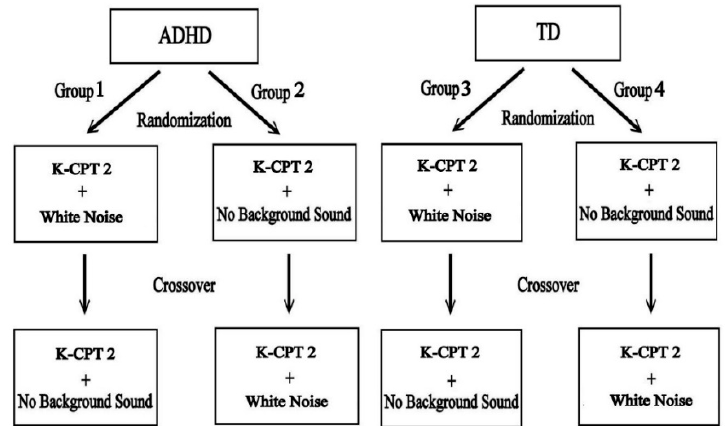
Figure 1. The crossover design in this study. Note: ADHD = preschoolers with attention-deficit/hy- peractivity disorder; TD = typically. Developing preschoolers. K-CPT 2 = The Conners Kiddie Con- tinuous Performance Test—Second